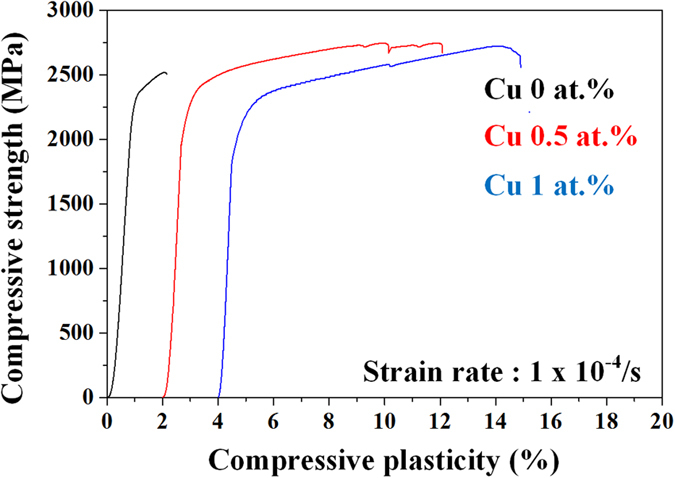
Engineering compressive stress-strain curves of the as-cast Co65−xCr13Mo22Cux alloys with x = 0, 0.5 and 1 at.%.